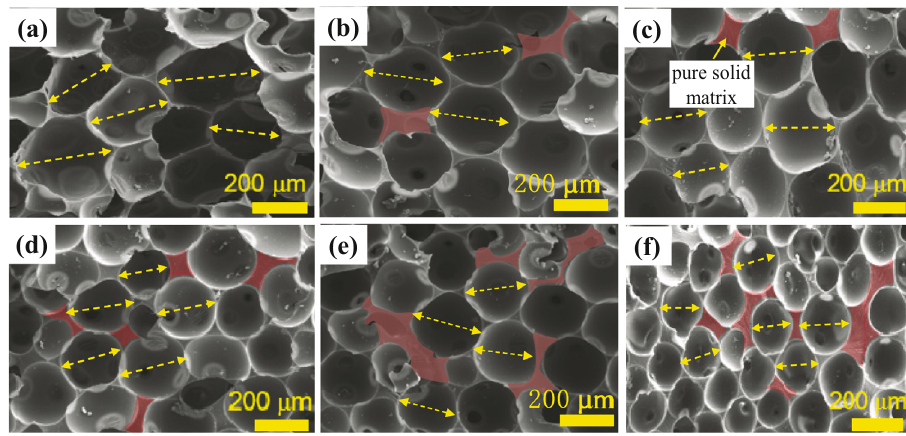
Figure 3: The micromorphology of the TFPU grouting materials with a density of: ( a ) 0.15, ( b ) 0.21, ( c ) 0.24, ( d ) 0.38, ( e ) 0.40, and ( f ) 0.46 g · cm − 3 .